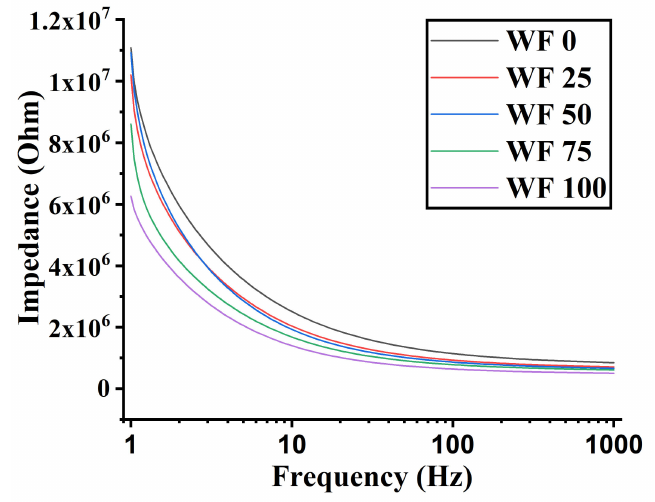
Figure 8. Graphs representing impedance of various